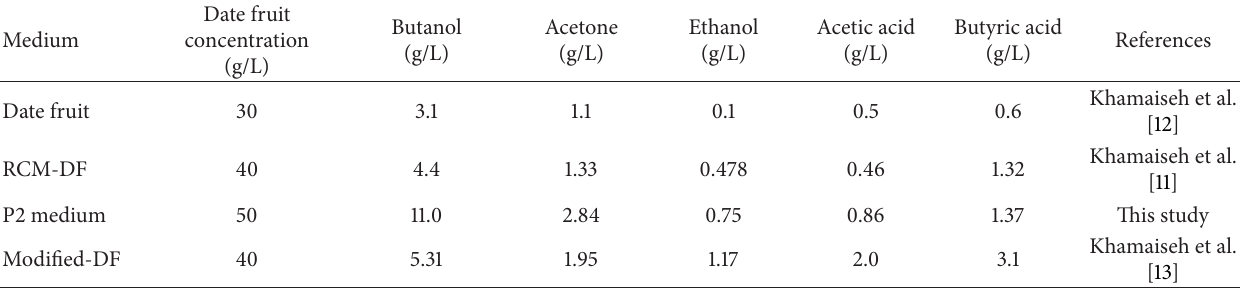
Table 2: A comparison of butanol, acetone, ethanol, acetic acid, and butyric acid production from date fruit with different modified media in batch culture using C. acetobutylicum NCIMB